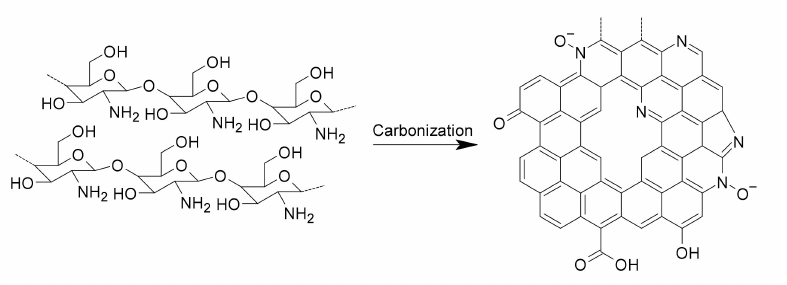
Figure 5. Chemical structure of sp 2 carbon produced after heat treatment of a carbohydrate